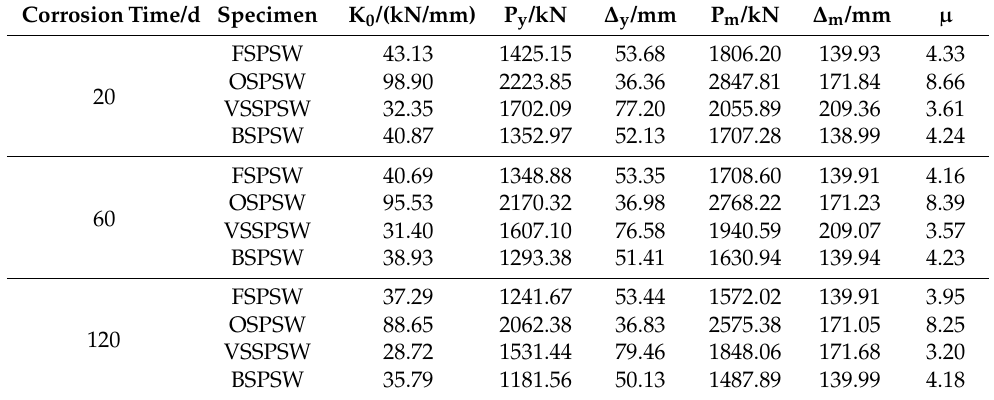
Table 7. Characteristic results of FSPSW, OSPSW, VSSPSW, and BSPSW at diverse corrosion days. Corrosion Time/d